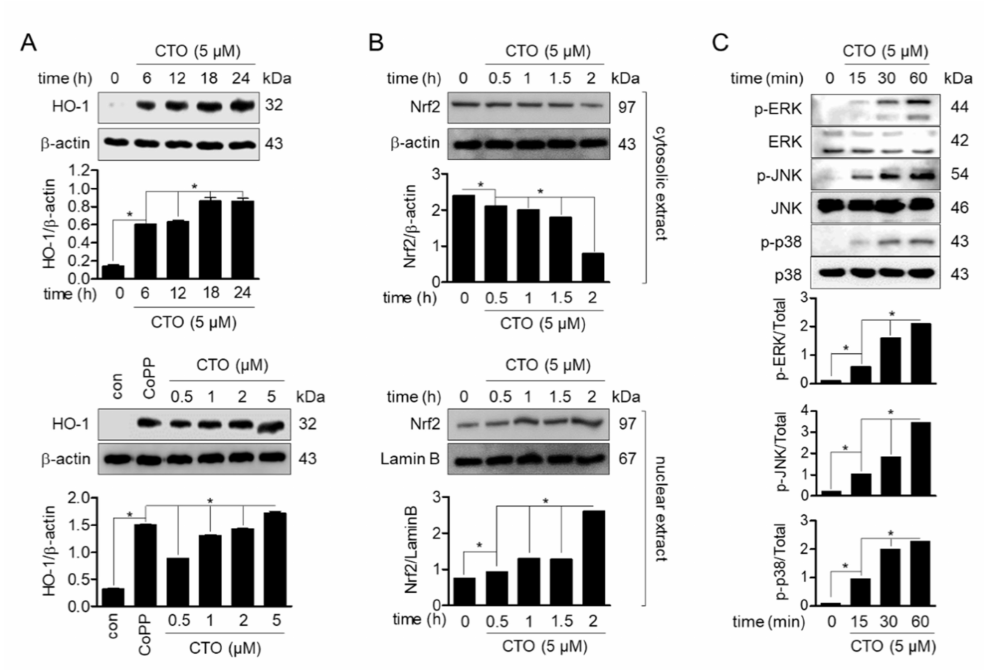
Figure 2. CTO induces heme oxygenase-1 (HO-1) expression by the promotion of Nrf2 translocation. ( A ) The cells (5 × 10 5 cells / mL) were treated with 5 µ M for the indicated time (0, 6, 12, 18, 24 h) or with the indicated concentrations of CTO (0.5, 1, 2, and 5 µ M) and cobalt protoporphyrin (CoPP) (20 µ M) for 18 h. The induced HO-1 expression was detected by Western blot analysis. ( B ) The translocation of Nrf2 was analyzed by Western blot analysis from cells treated with 5 µ M of CTO for the indicated time. ( C ) The cells were treated with 5 µ M CTO for the indicated times (0–60 min) and phosphorylation of ERK1 / 2, JNK and p38 were determined by Western blot analysis. * p < 0.05 was considered significant di ff erences between groups are